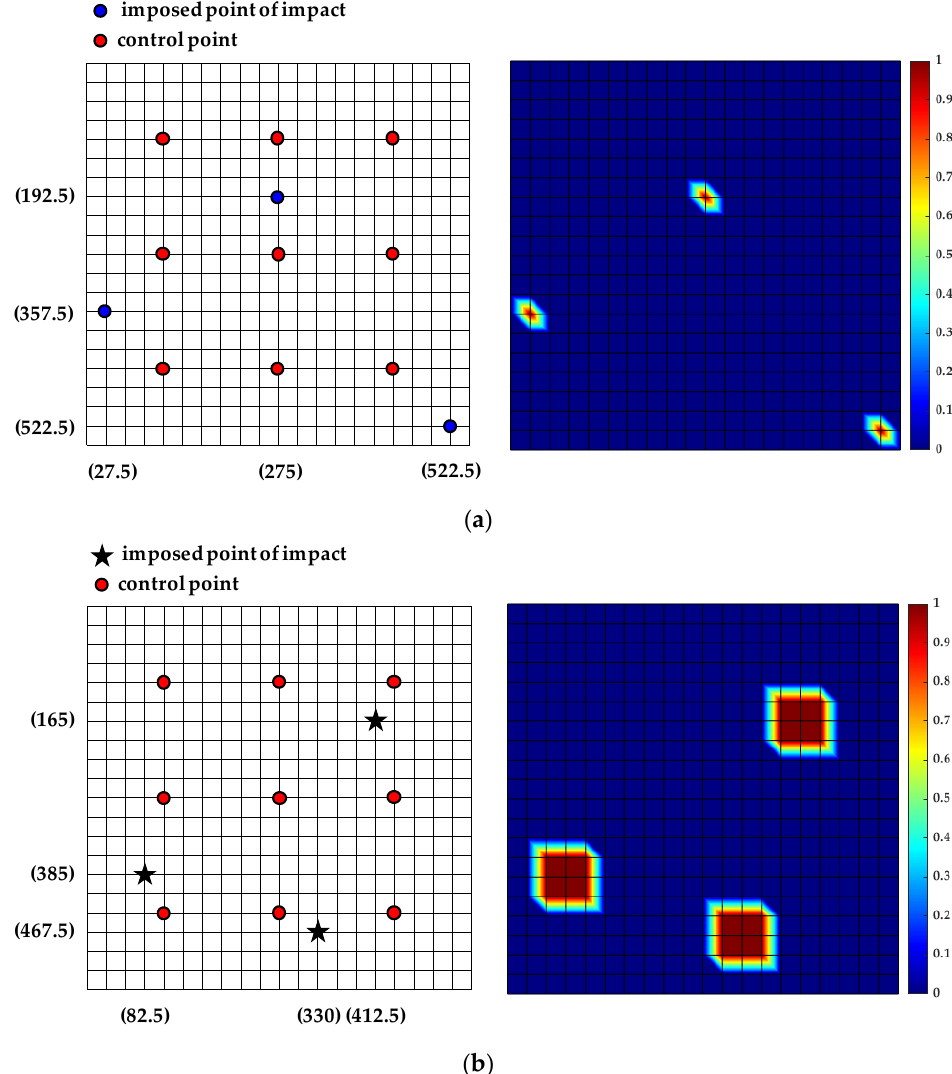
Figure 9. Impact position detection on a FE based ANN: ( a ) autocorrelation with points 18, 29, and 49; ( b ) verify of geometric coordinates (x, y) with data unknown to the ANN (82.5, 385), (330, 467.5), and (412.5, 165).